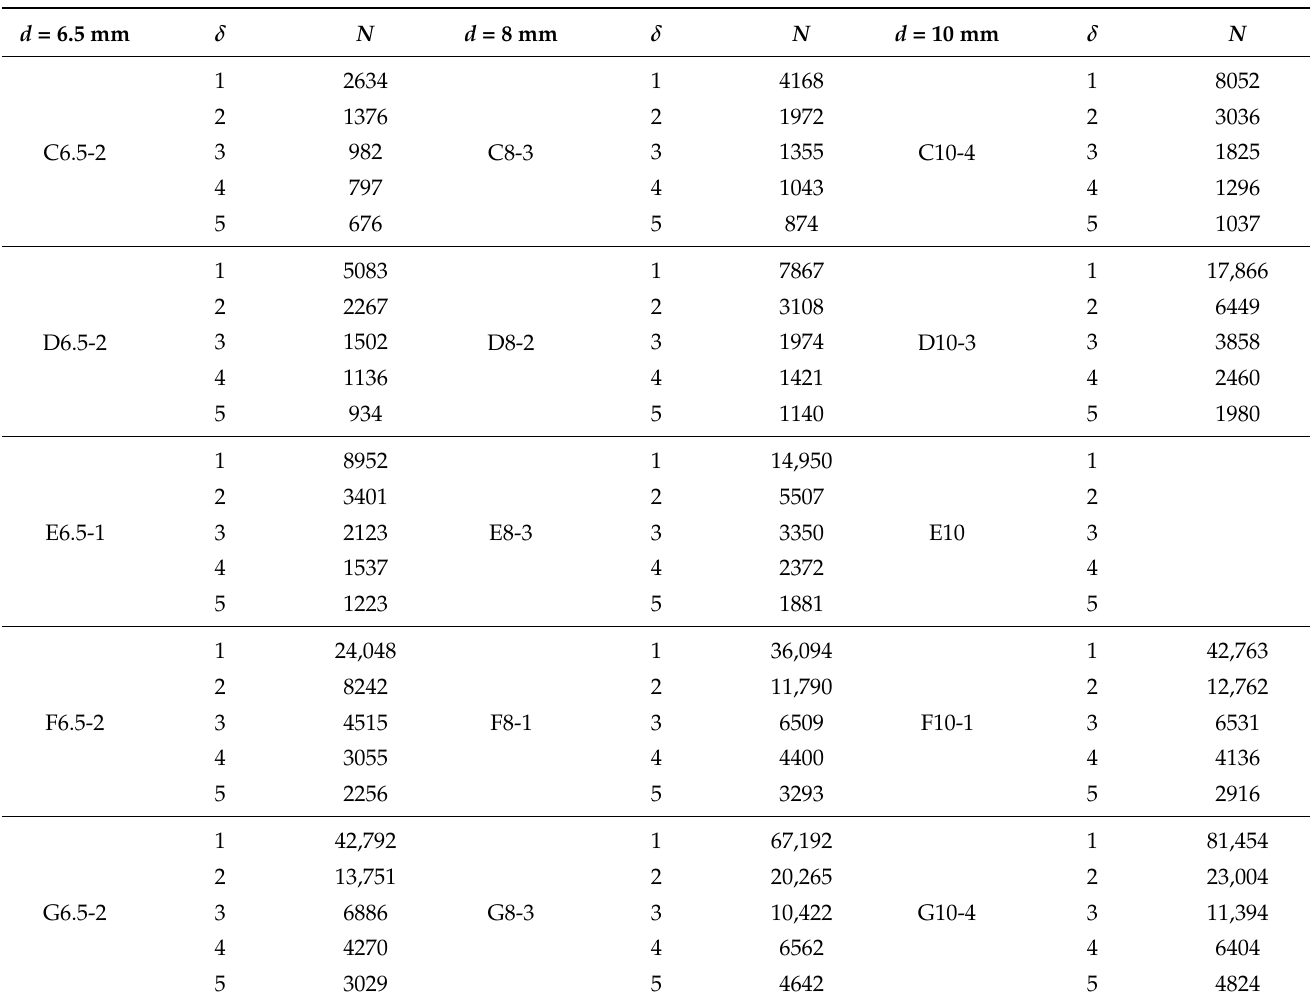
Table 3. Calculation parameters δ and N of fractal